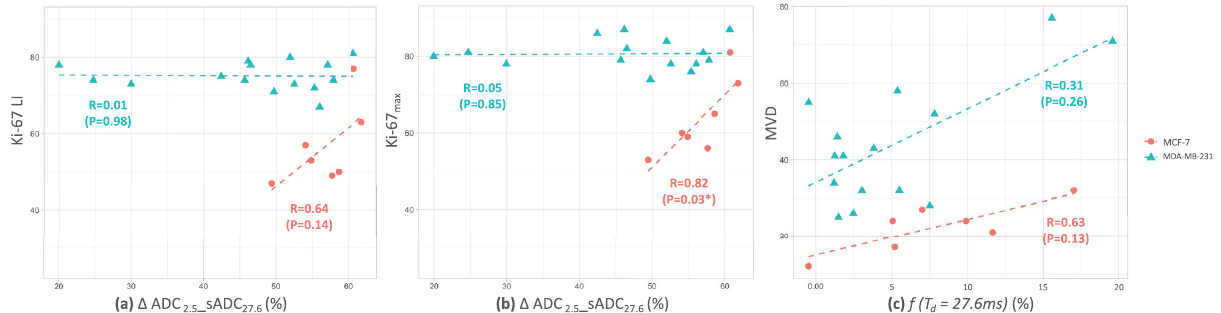
Figure 4. Scatter plots of ( a ) ΔADC 2.5 _sADC 27.6 against Ki-67 LI, ( b ) ΔADC 2.5 _sADC 27.6 against Ki-67 max , and ( c ) f